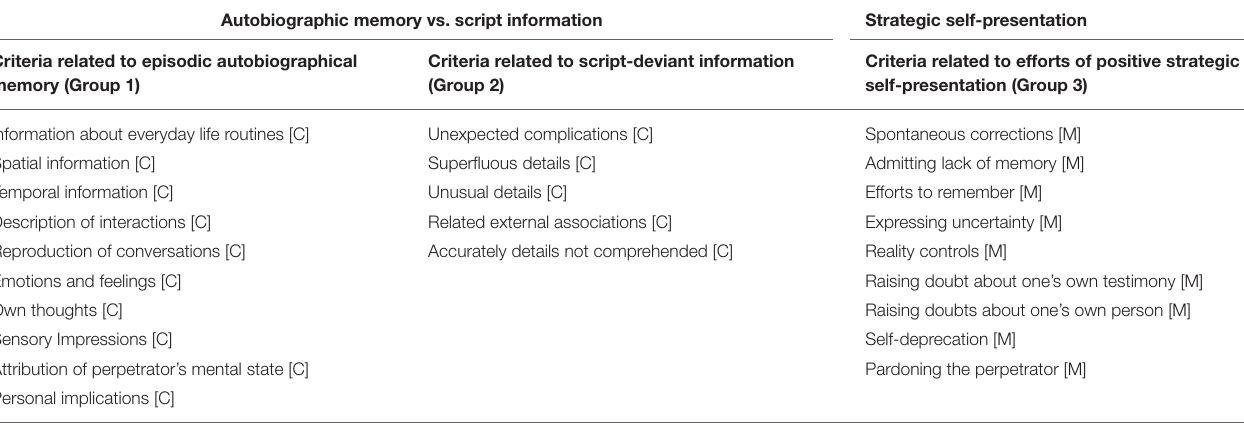
TABLE 3 | Modified system of content characteristics a (Volbert and Steller, 2014). Autobiographic memory vs. script information Strategic